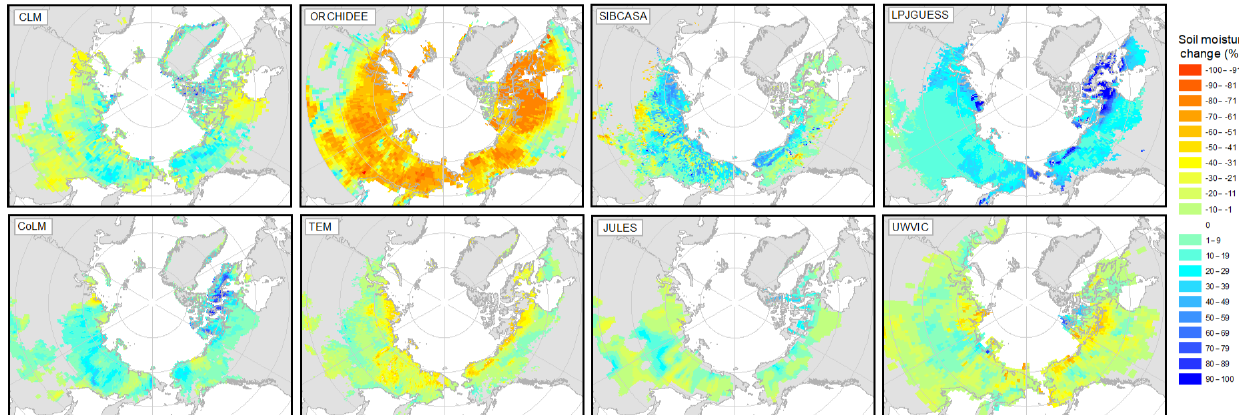
Figure 3. Spatial variability of projected changes in surface soil moisture (%) among models. Depicted changes are calculated as the differ- ence between the 2071 to 2100 average and the 1960 to 1989 average. Colored area represents the initial simulated permafrost domain of 1960 for each model.